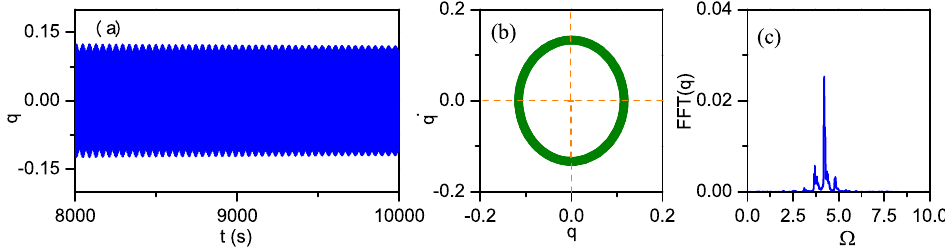
Figure 9. The primary resonance response with time delay τ = π , ( a ) The time history curves, ( b ) the phase diagram and ( c ) frequency power